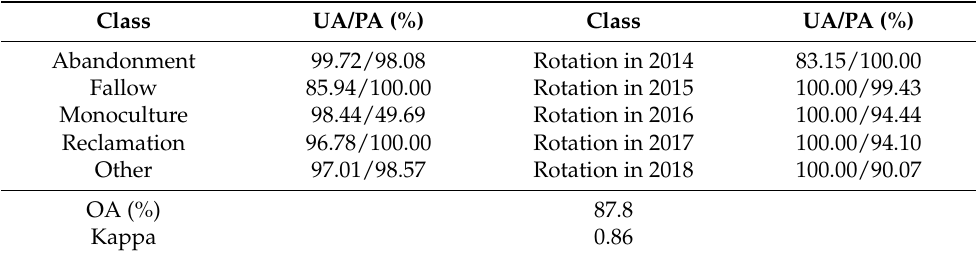
Figure 10. GIS-driven multi-year cotton-planting pattern from 2014 to 2018. Table 5. Accuracy assessment of GIS-driven cotton cropping